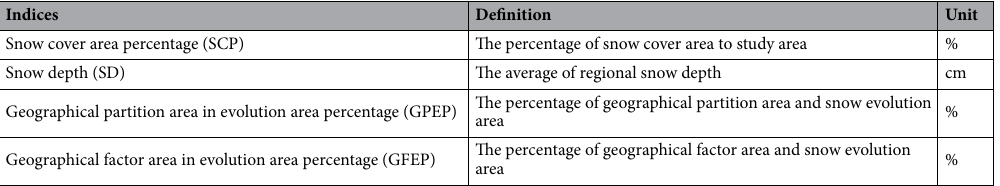
Figure 2. Workflow.